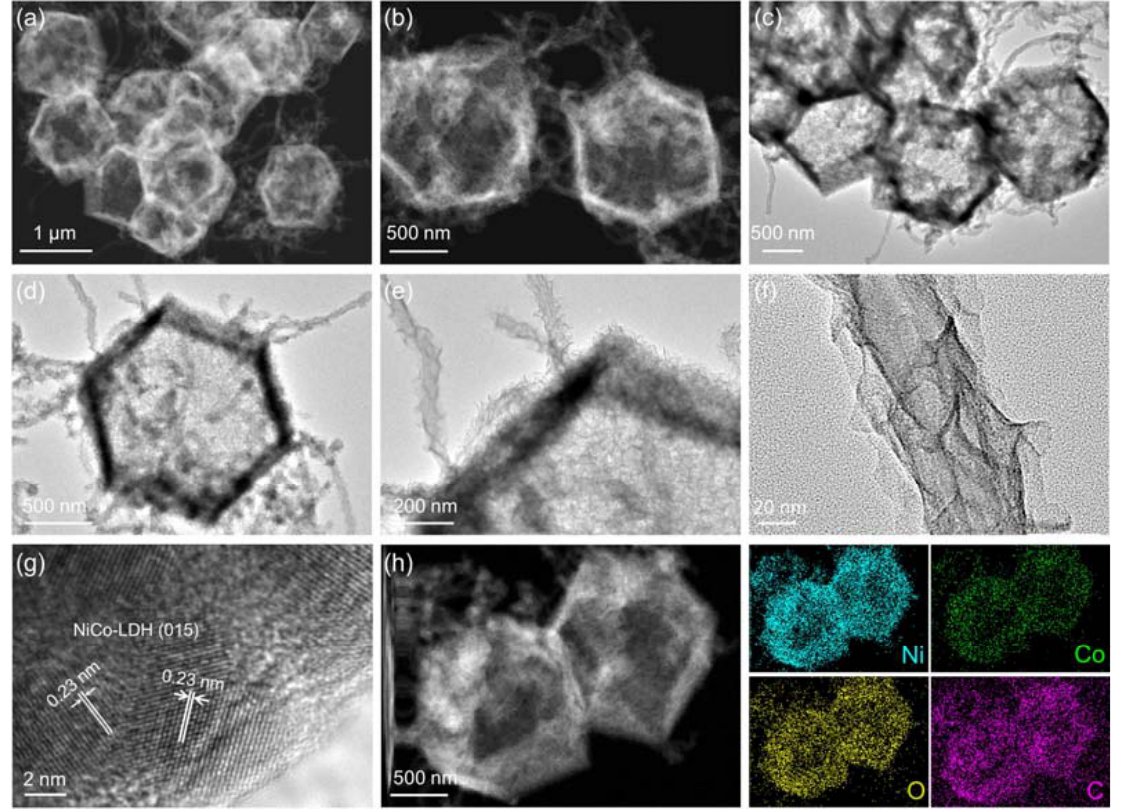
Figure 4. Morphology and structure characterization of NiCo ‐ LDH RDC@CNTs: ( a – b ) HADDF ‐ STEM images, ( c – f ) TEM images, ( g ) HRTEM image, and ( h ) HADDF ‐ STEM image and corresponding EDS element mapping profiles.